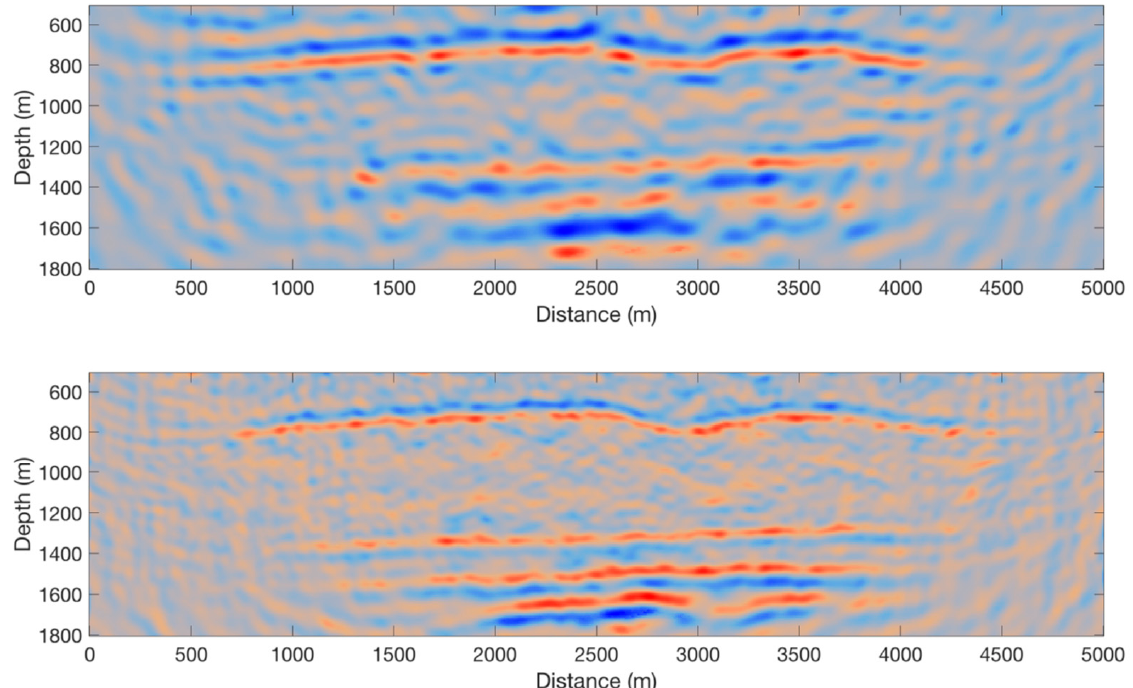
Figure 5. Stable components (projection onto the highest right singular vectors) of depth reflector reconstruction for (cid:4666)(cid:1848) (cid:3043) , (cid:1848) (cid:3046) (cid:4667) parametrization. Top— (cid:1870)(cid:1848) (cid:3043) projection, bottom— (cid:1870)(cid:1848) (cid:3046) the projection for the truncated operator condition number 10 (cid:2869) .